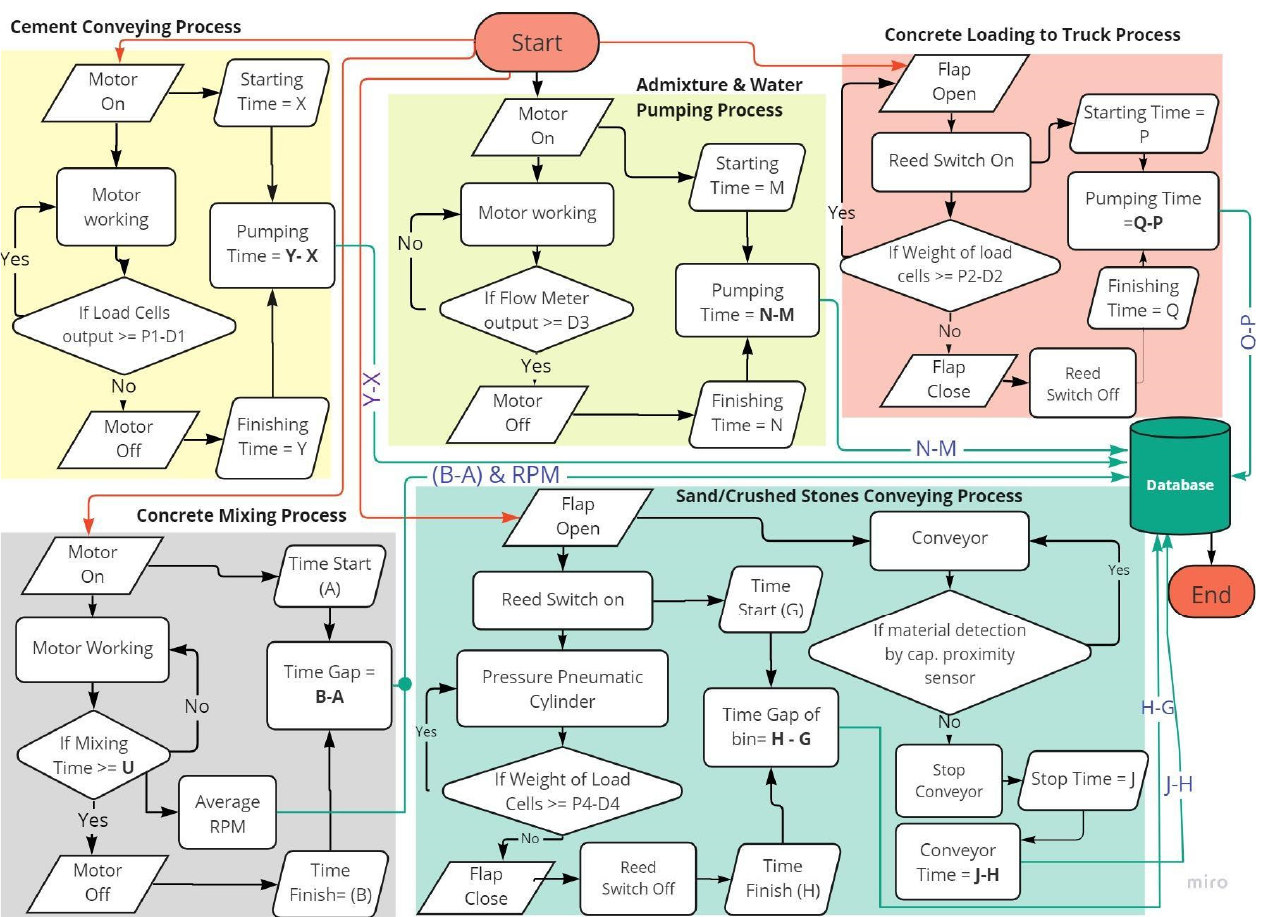
Figure 8. Flow Chart of Logical Functionality of Proposed DT Solution. Table 5. Parameter Notations Used in Flow Chart of DT Functionality.